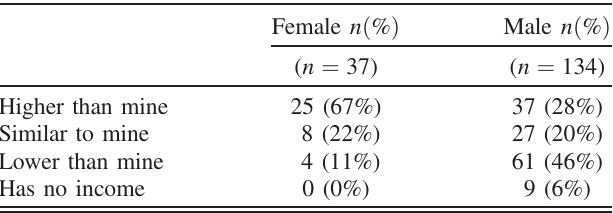
TABLE VIII. Results for the following question: Compare